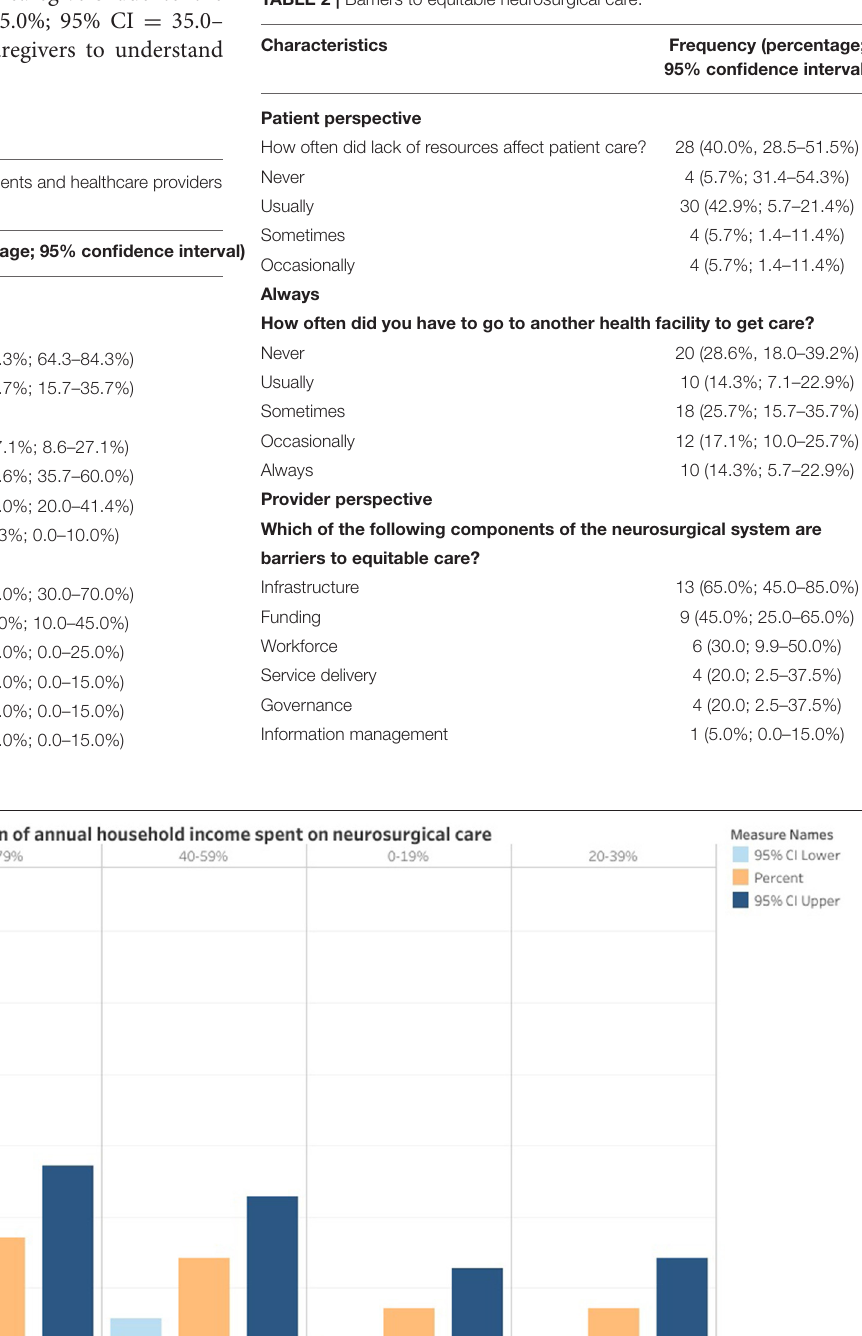
TABLE 2 | Barriers to equitable neurosurgical care.